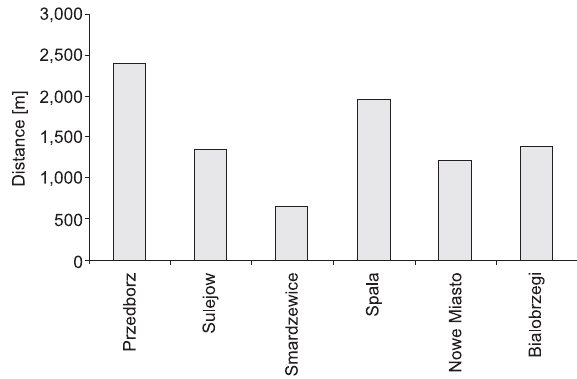
Fig. 5. Distance of the dwelling to the river network in the Pilica River sub-catchments obtained from CORINE–2006 and hydrographic buffer zone